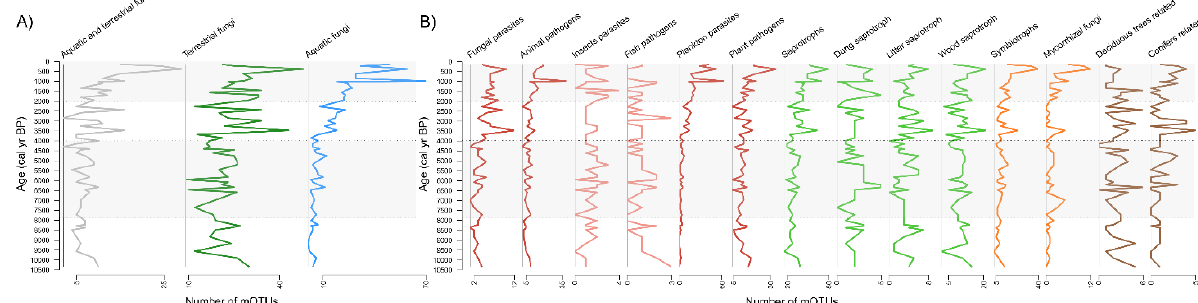
Figure 3. Changes in ( A ) richness of fungi and ( B ) in distributed ecophysiological groups over 10.5 kyr. Dotted lines with colored backgrounds illustrate time periods.